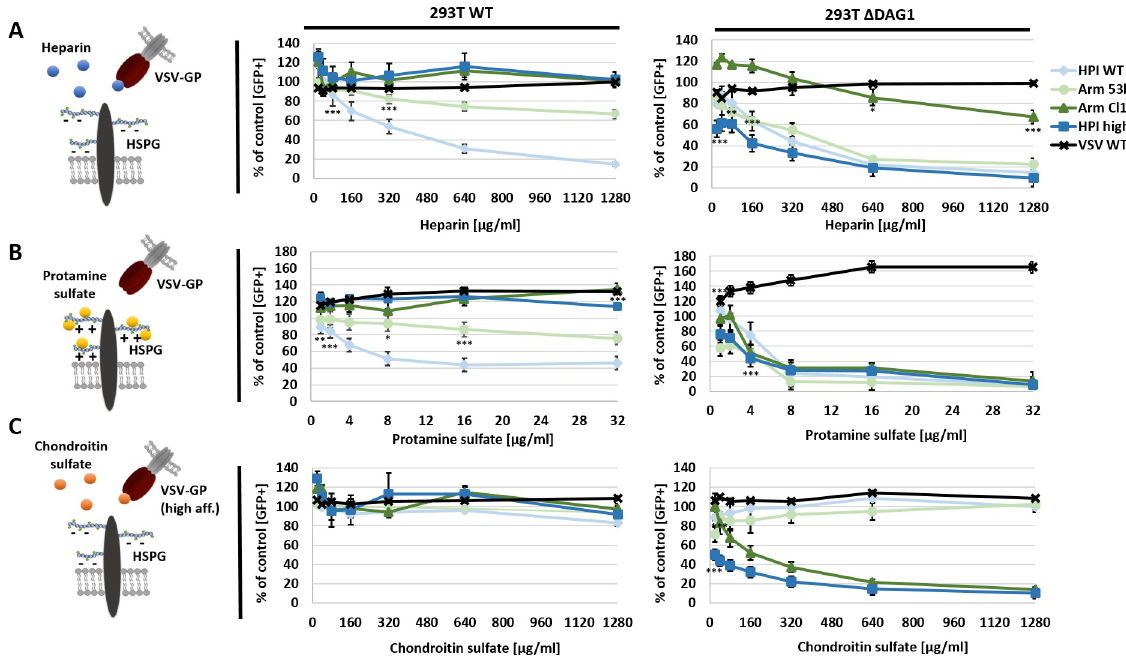
Fig 4. Treatment with soluble HS or PS efficiently inhibits infection of low affinity VSV-GP variants. VSV WT or VSV-GP variants (MOI 1) were incubated with 0, 20, 40, 80, 160, 320, 640 or 1,280 μ g/ml of soluble (A) HS or (C) CS for 2 h at 4˚C in a total volume of 50 μ l PBS and afterwards used to infect 293T WT or Δ DAG1 cells for 1 h at 37˚C. To analyse the effect of (B) PS, cells were treated with 0, 1, 2, 4, 8, 16 or 32 μ g/ml PS for 1 h at 37˚C and subsequently infected with low or high affinity VSV-GP variants (MOI 1). Infection was quantified by flow cytometry measuring eGFP signal 15 h p.i. and is given relative to non-treated cells infected with the corresponding virus. Shown are the means ± SD of three replicates. Statistical analysis was performed using one-way ANOVA, followed by Turkey’s multiple comparison test; � p < 0.05, �� p < 0.001, ��� p < 0.0001 (added below data